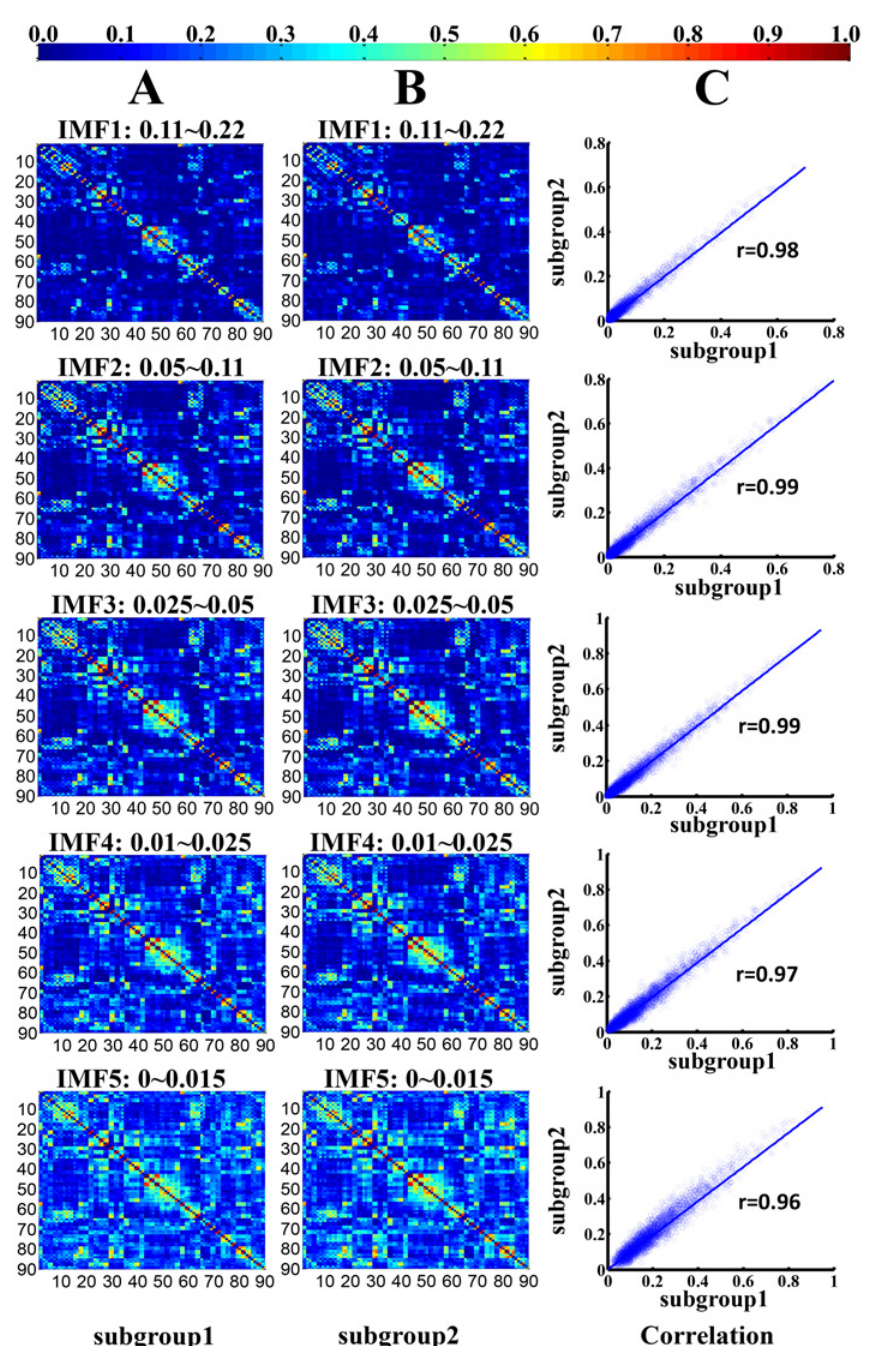
Fig 5. Split-half reproducibility of the frequency dependent functional connectivity weighted networks. (A) and (B) represent the group-mean frequency specific FC weighted networks of two specific subgroups in each IMF component. (C) denotes the corresponding correlation maps between each pair of frequency specific FCNs in the two subgroups.